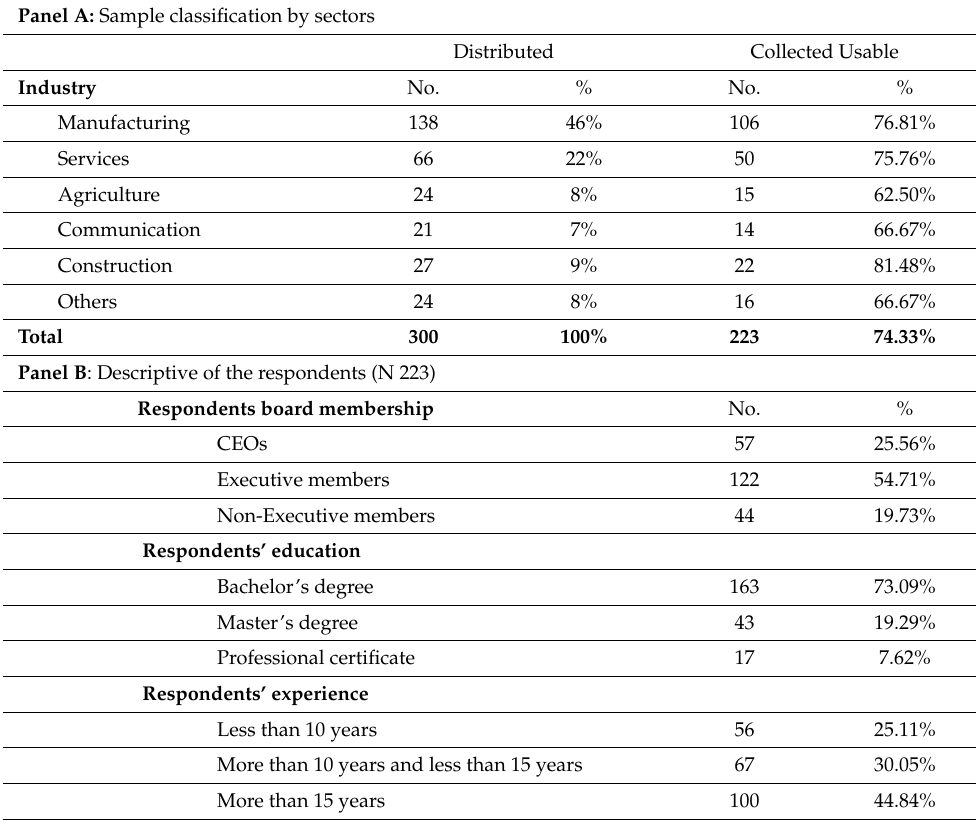
Table 1. Sample Responses Classification by Sectors and Respondents. Panel A: Sample classification by sectors